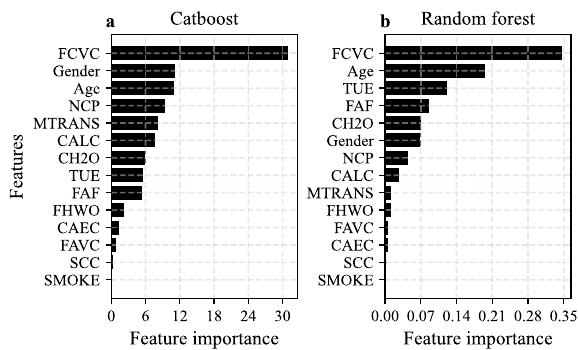
Figure 1. Feature importance for predicting BMI of overweight and obese people using; ( a ) catboost, ( b ) random